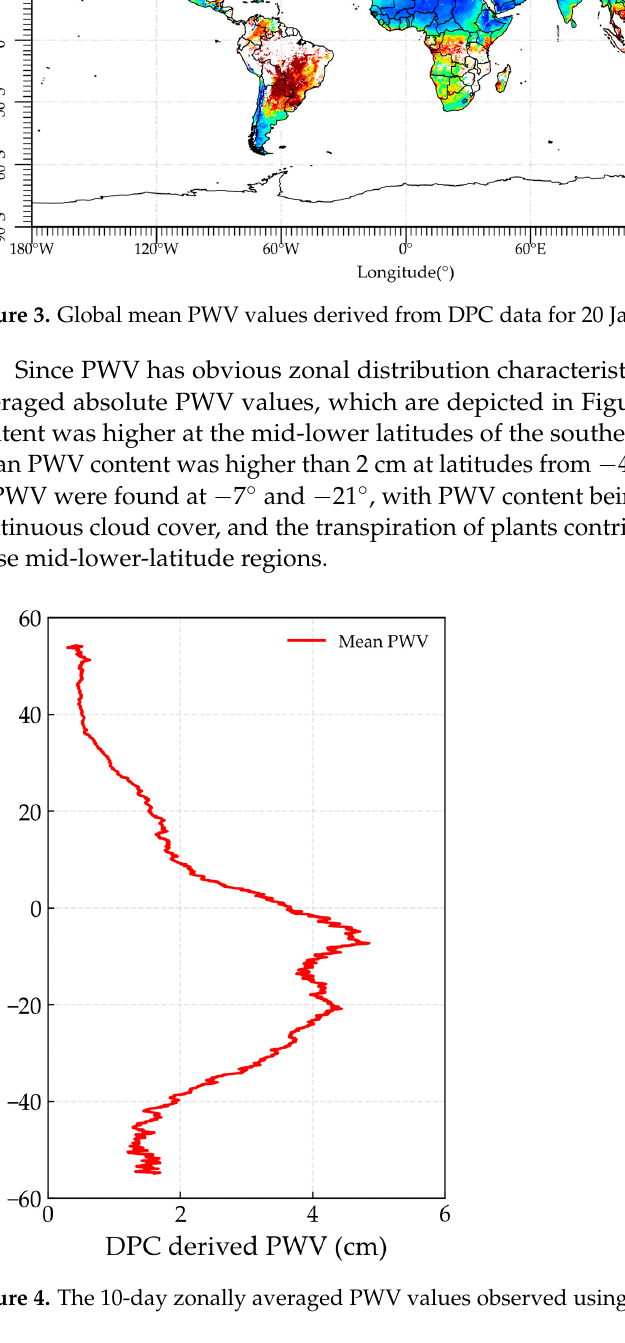
Figure 5. Global mean PWV variation from 20 January 2022 to 29 January 2022.